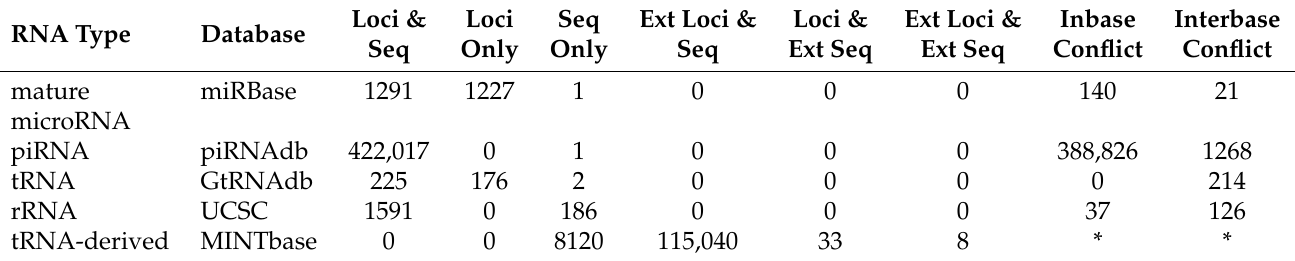
Table 2. Statistics on correction events in human RNA transcript entries: cases when both locus and sequence were present ( Loci & Seq , no correction), only locus or only sequence ( Loci only , Seq only , sequence or locus retrieved from genome); cases that required extending entry’s locus, sequence or both ( Ext Loci & Seq , Loci & Ext Seq , Ext Loci & Ext Seq ); cases with transcript loci intersections within same database ( Inbase conflicts ) and intersections between different databases ( Interbase conflicts ). * No intersection events were considered for tsRNAs, as fragments of the same tRNA naturally have intersecting